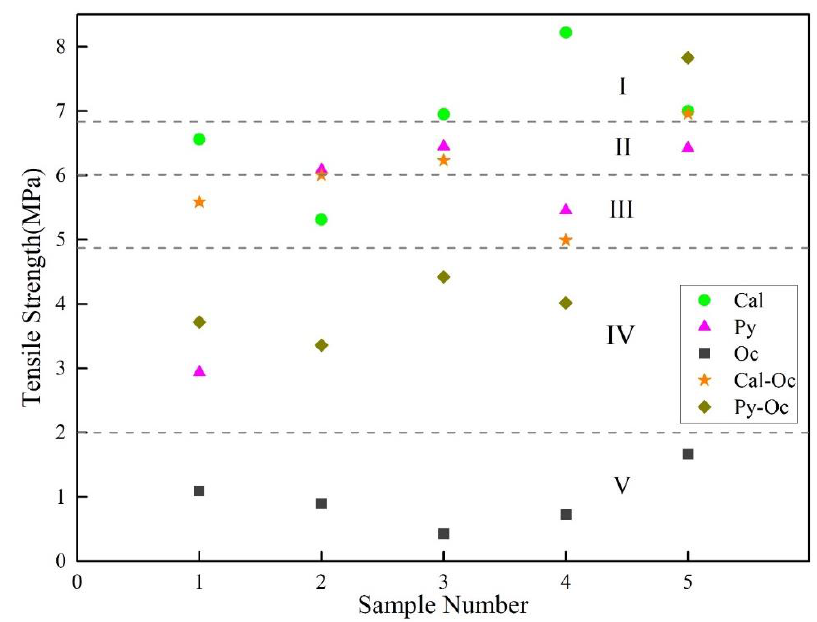
Figure 5. Distribution of Brazilian tensile strength of shale laminae. The tensile strength of the Longmaxi Shale laminae is classified into five levels (I, II, III, IV, V, mainly corresponding to Cal, Py, Cal-Oc, Py-Oc, and Oc, respectively).